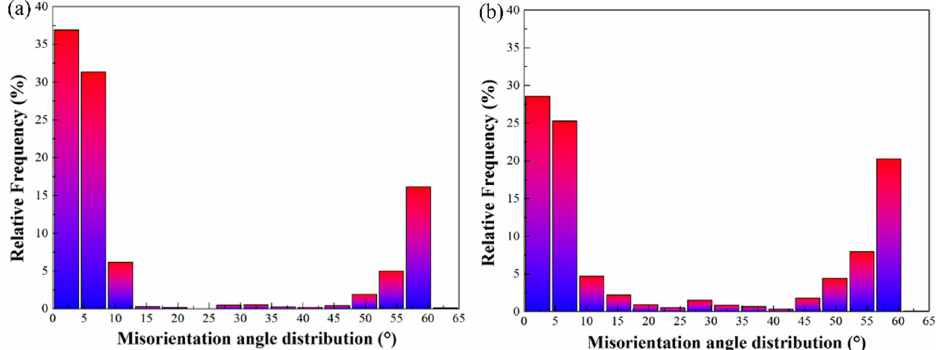
Figure 7. Misorientation angle distribution: ( a ) prior to tempering treatment and ( b ) subject to tempering treatment.